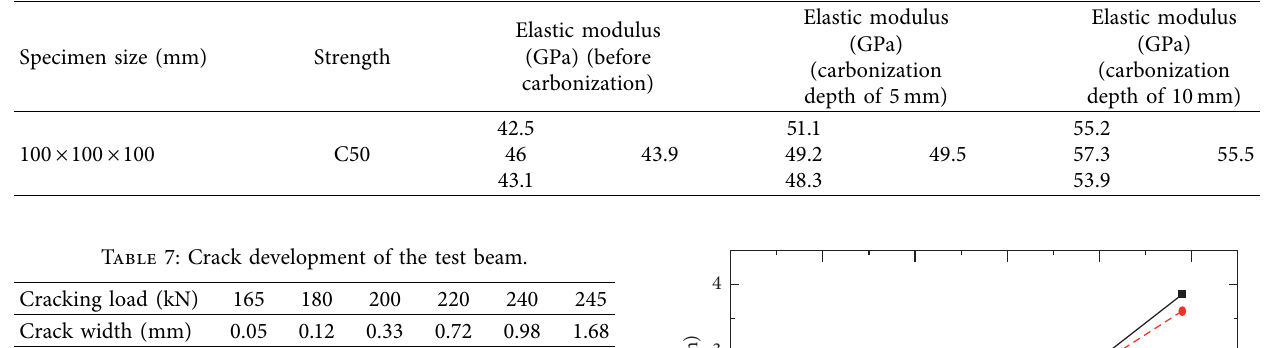
Table 6: Elasticity modulus of the standard specimen under carbonization erosion.